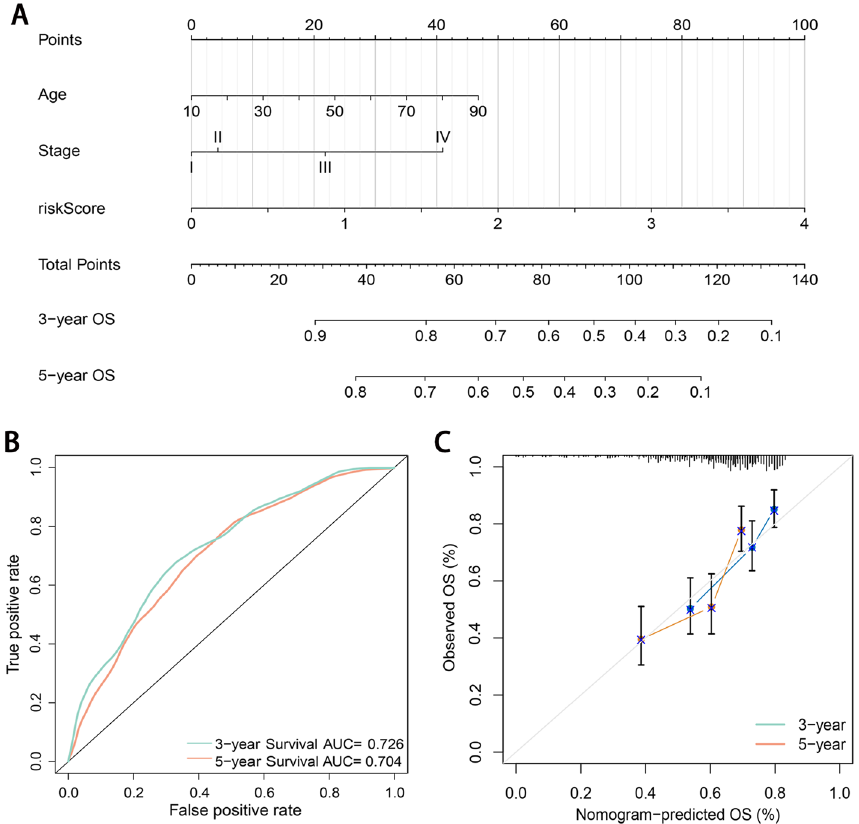
Figure 7. Construction and validation of the nomogram. ( A ) Nomogram for predicting 3-year and 5-year OS of melanoma patients incorporating independent prognostic factors from multivariate Cox proportional hazards regression. ( B ) AUCs of time-dependent ROC curves at 3- and 5-year OS for the independent prognostic factors. ( C ) Calibration curves corrected for deviations in agreement between the predicted and observed OS rates at 3 and 5